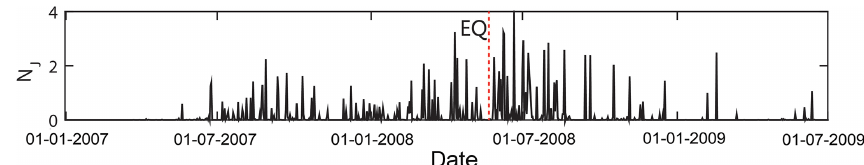
Figure 7. Estimated expected frequency N J under the optimal threshold k ∗